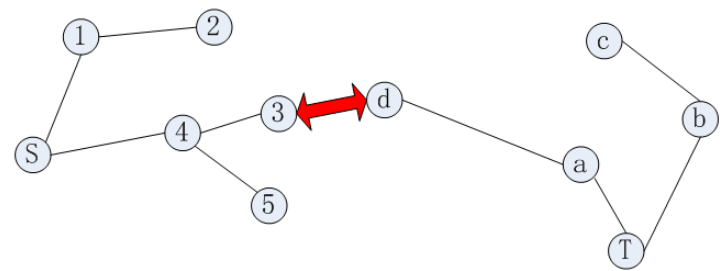
Figure 2. Principle of bidirectional RRT* extension.